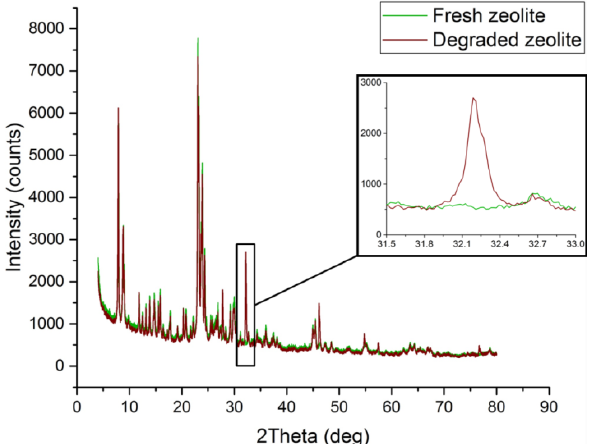
Figure 2. XRD patterns of fresh ( green ) and degraded ( red ) zeolite samples; (insert) zoom on the 31.5–33° range to highlight one peak of the AgCl Chlorargyrite CFC (PDF 85-1355).